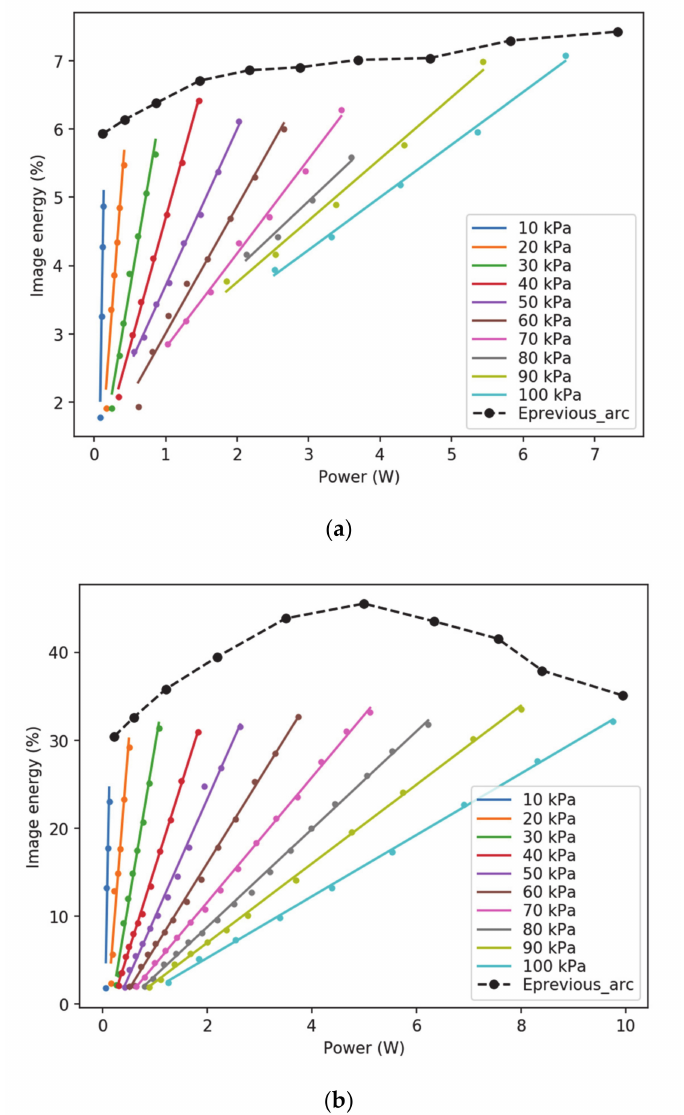
Figure 7. Energy of the images versus the electrical power dissipated by the PDs. The dashed black line ( E Previous_arc ) sets the limit energy just before arc occurrence. ( a ) Positive DC supply. ( b ) Negative DC